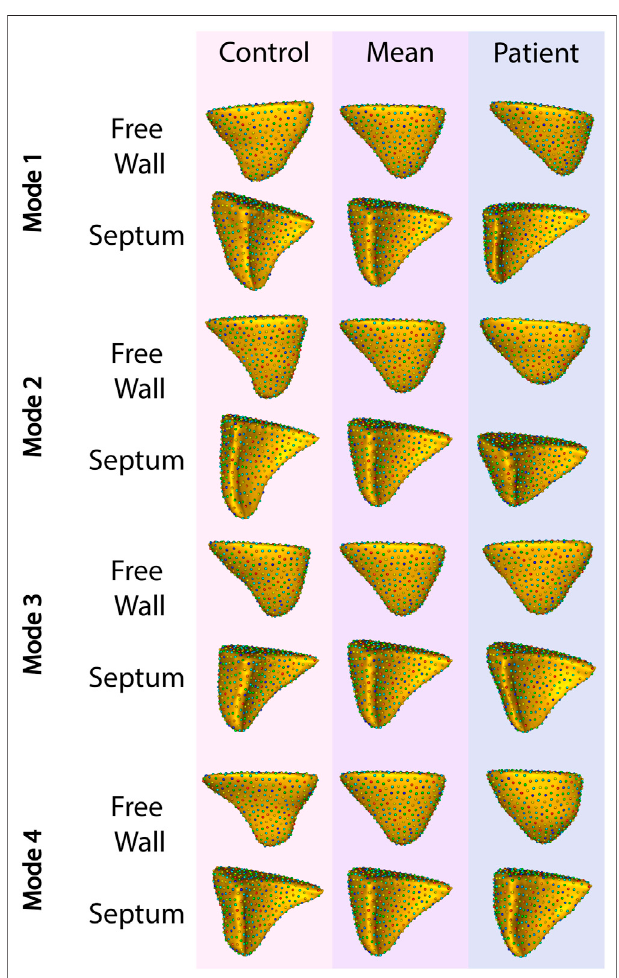
FIGURE4| Thefourprimarymodesofshapevariationbetweenpatients with TR and controls. The control group is shown in the leftmost column, patient group in the rightmost, and the overall mean in the